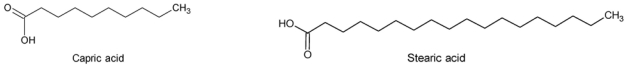
Structure of compounds found in species of Gracilaria with antifungal activity.